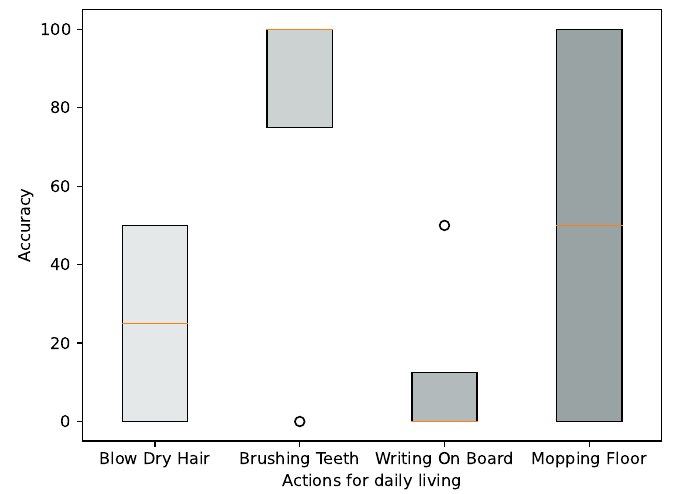
Figure 9. Results for patient UAH-1 based on LOLA’s actions monitoring system.